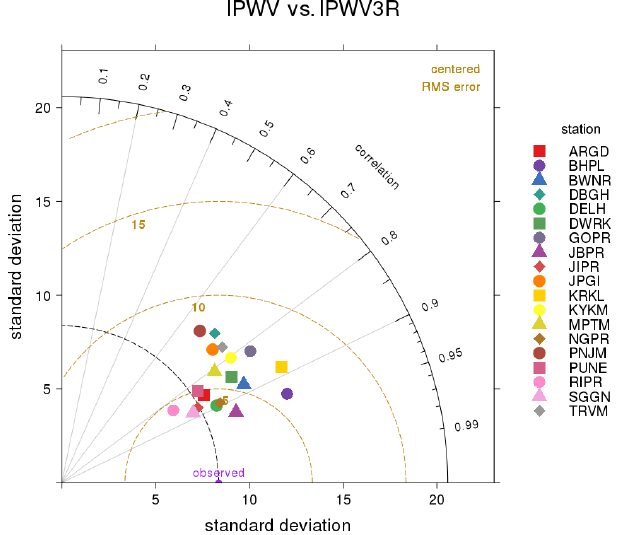
Figure 3. Taylor diagram of INSAT-3DR vs. Indian GNSS re- trievals.